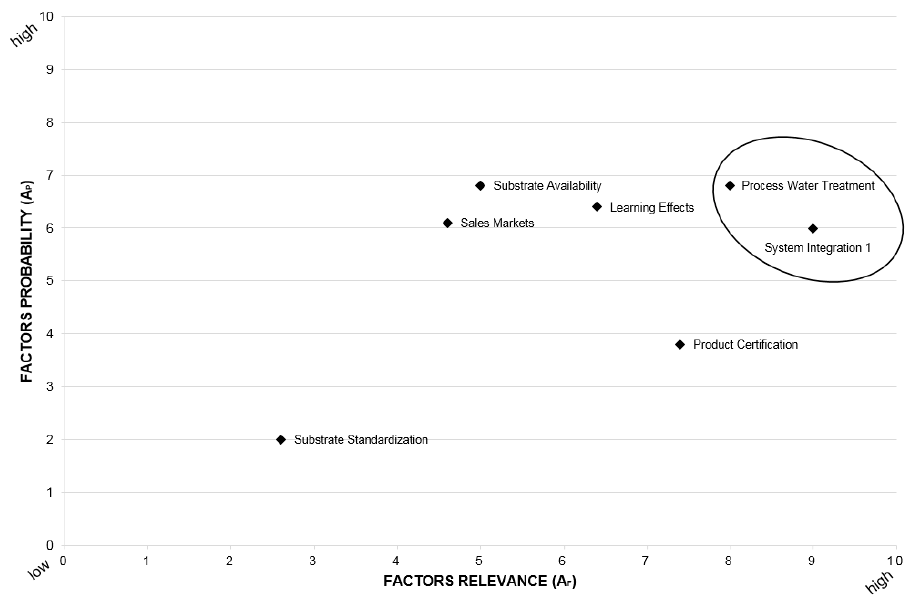
Figure 4. Combination of relevance and probability of consensus factors after defuzzification.